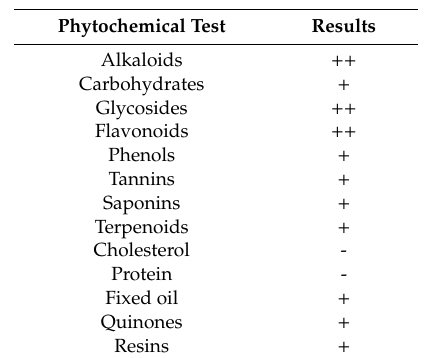
Table 1. Qualitative phytochemical screening of methanol extract of B. pilosa